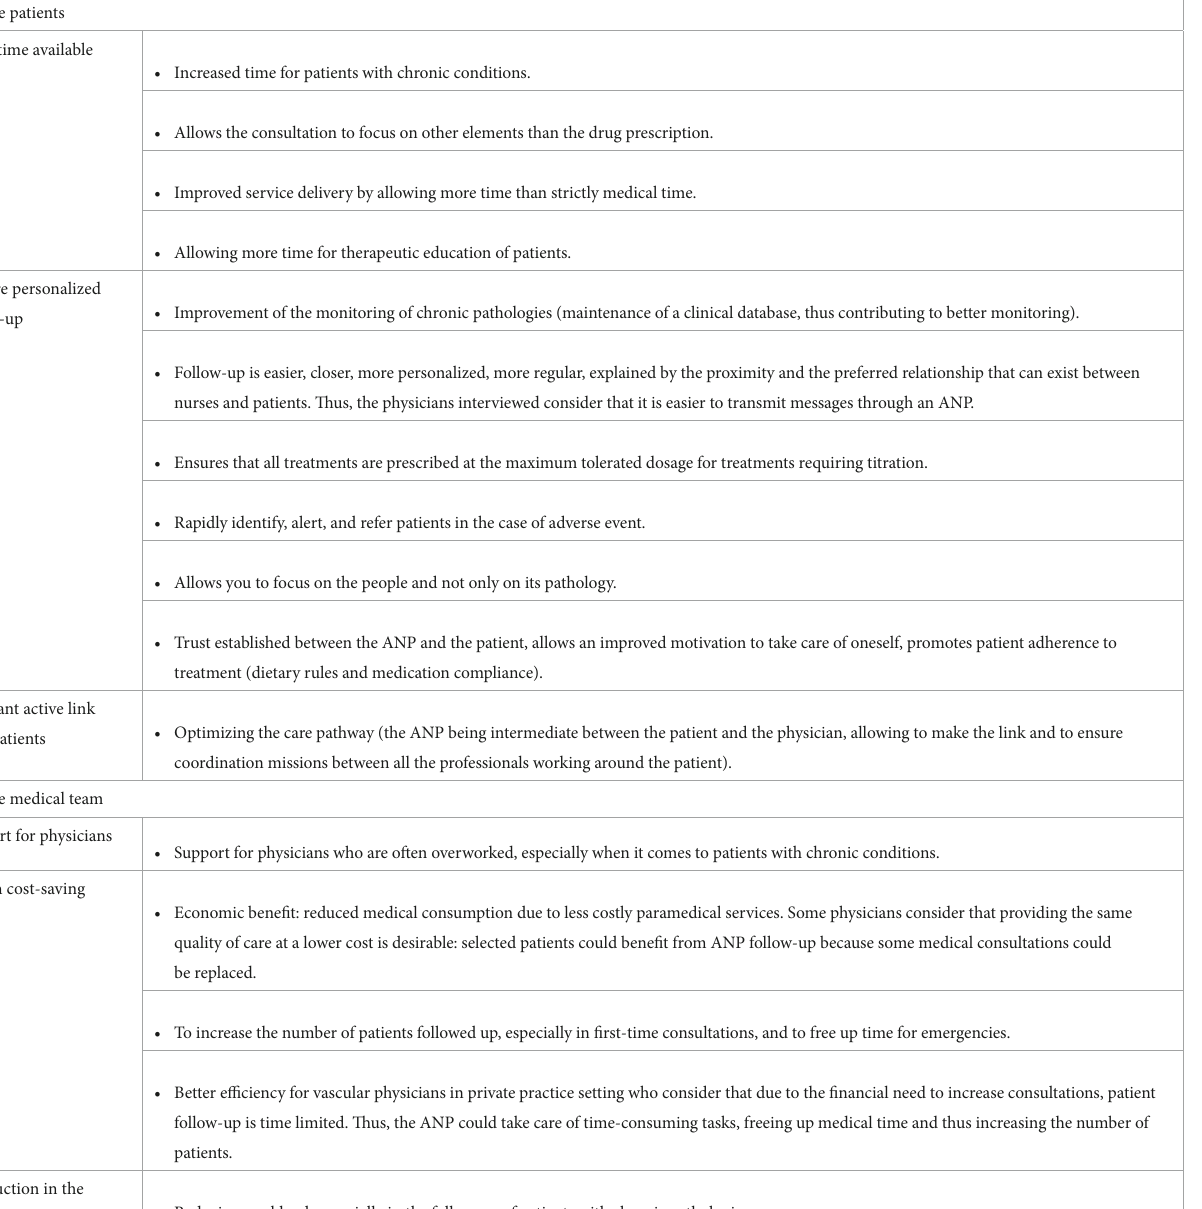
TABLE 2 Summary of the benefits of an Advanced Nurse Pactitionner (ANP) within the ‘vascular team’. For the patients More time